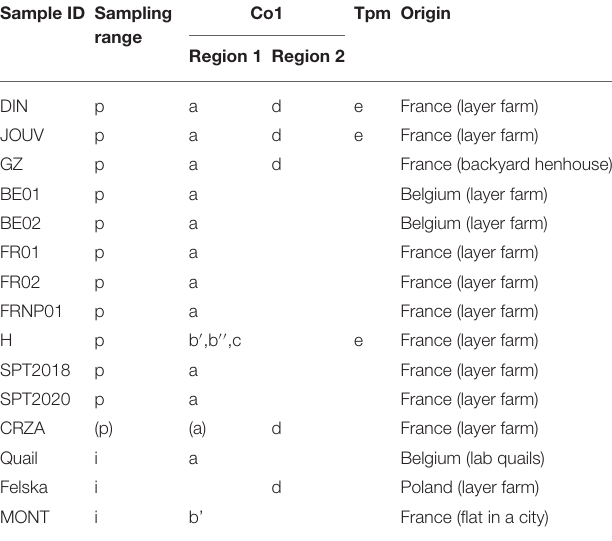
TABLE 2 | Information on new data.